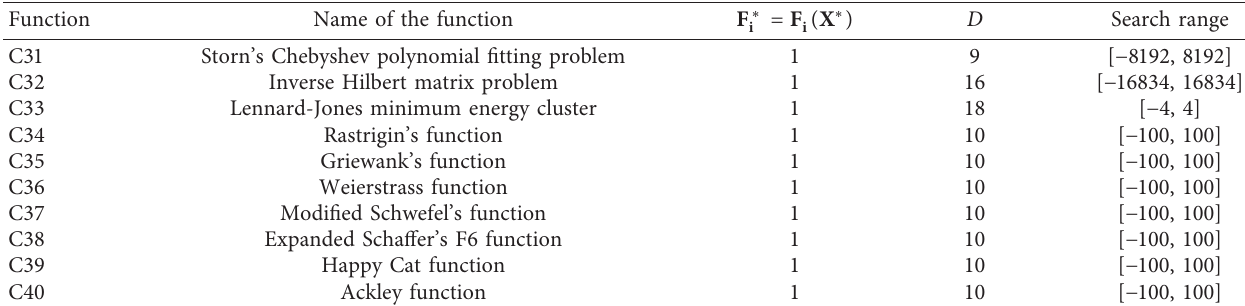
Table 2: CEC2019 test